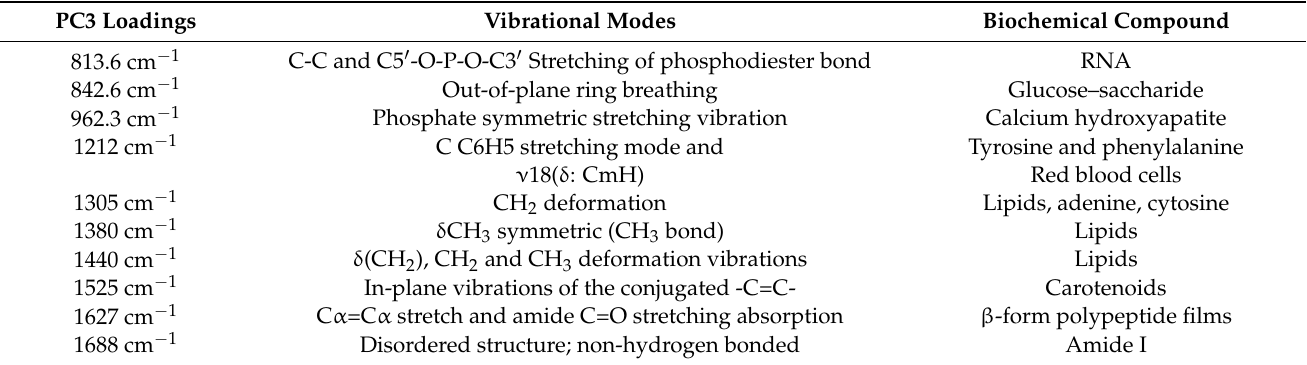
Table 3. Vibrational modes assigned to peaks of absolute values of PC3 loadings [61].